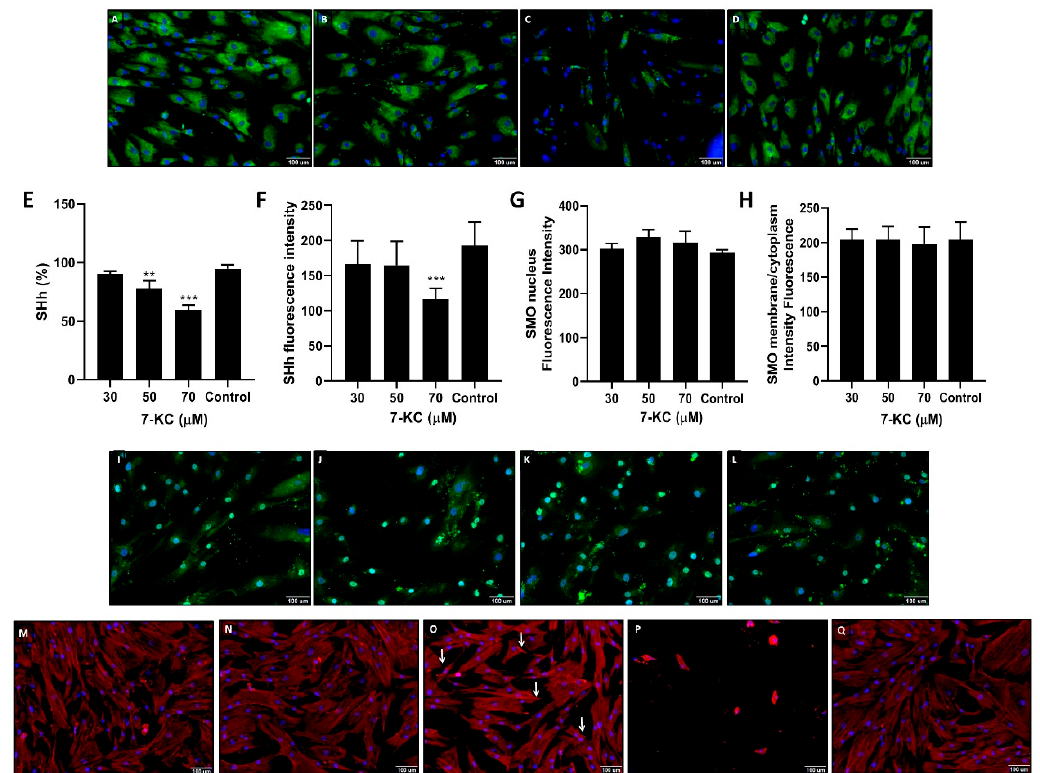
Figure 3. Sonic Hedgehog (SHh), smoothened (SMO), and changes in actin organization in